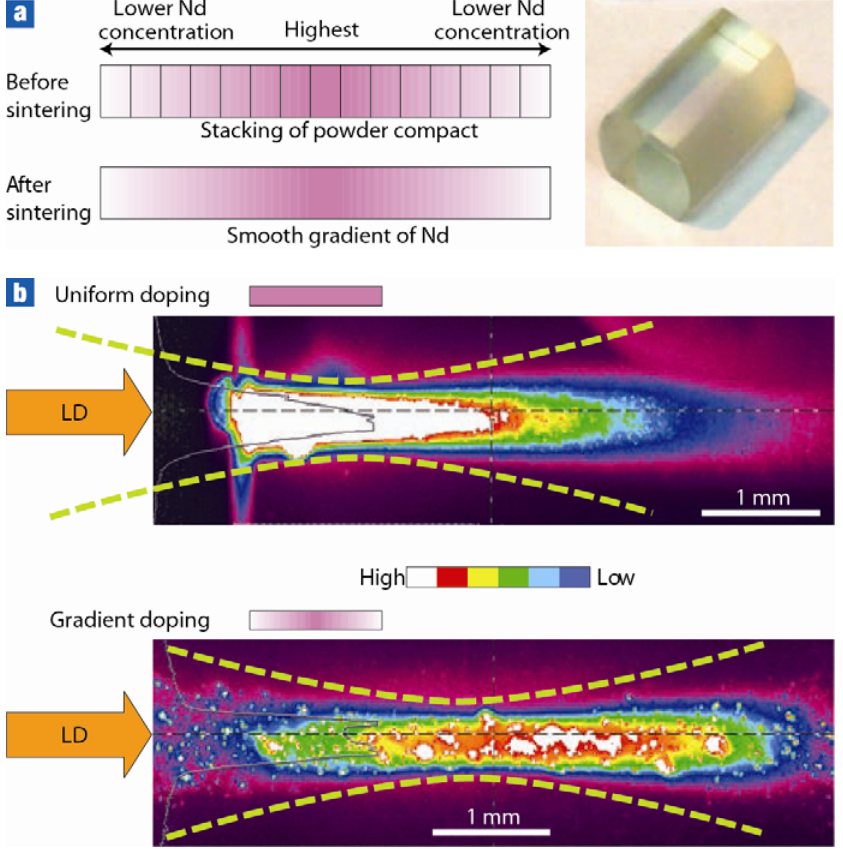
Figure 14. ( a ) Graded laser ceramics showing distribution of Nd ions before and after sintering and ( b ) better thermal management during lasing (Adapted from [31]).